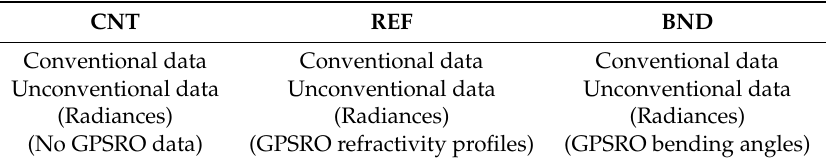
Table 3. Configuration of the experiments conducted in this